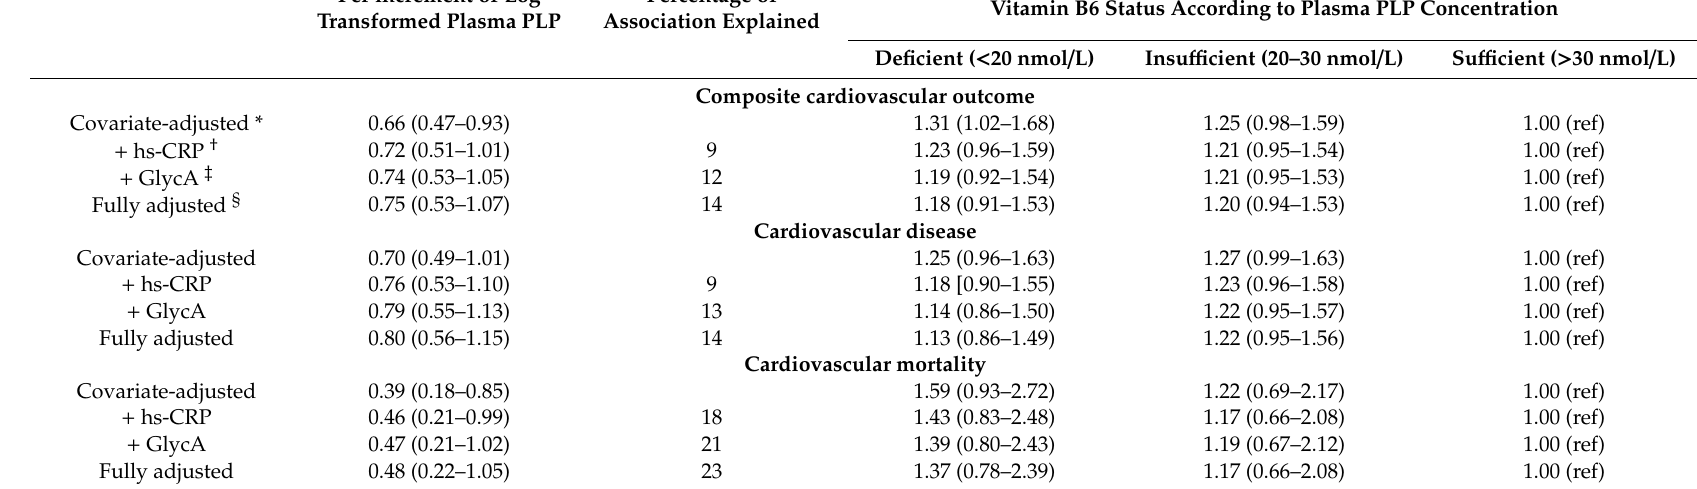
Table 3. E ff ect of adjustment for inflammation on the association between plasma pyridoxal 5’-phosphate and cardiovascular